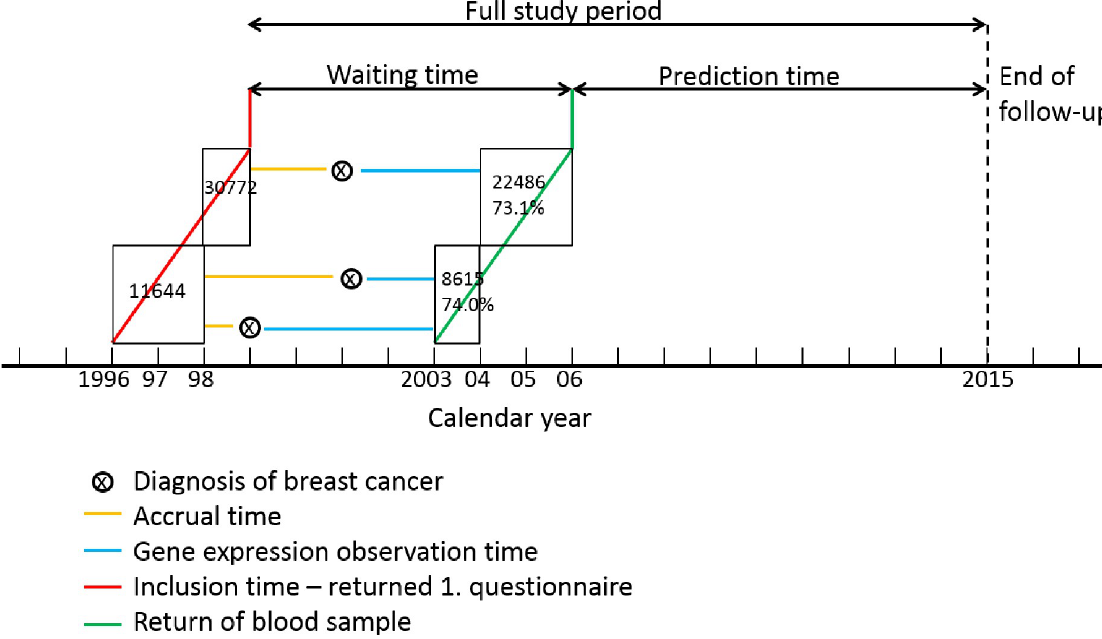
Fig 1. Design of the post-diagnostic study with definitions of the different observation times.